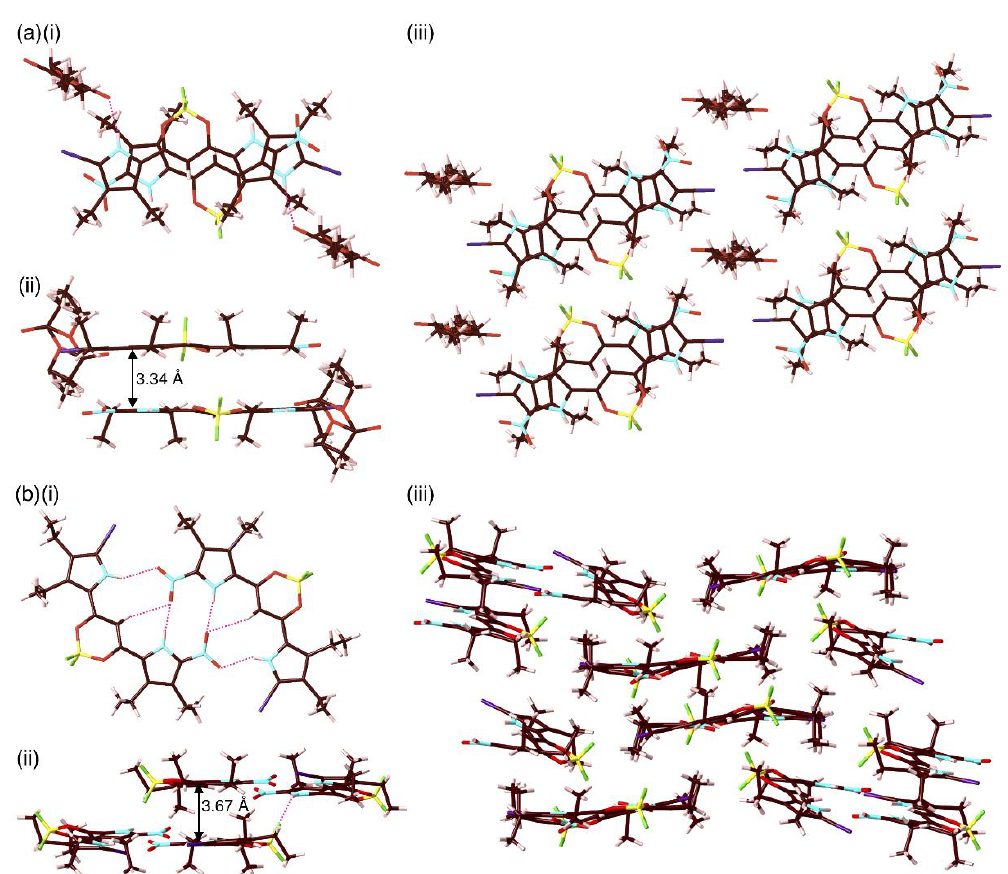
Figure 1. Single-crystal X-ray structures of ( a ) 2c -tri and ( b ) 2c -mono as ( i ) top and ( ii ) side views and ( iii ) packing diagrams. Atom color codes: brown, pink, yellow, cyan, red, green, and purple refer to carbon, hydrogen, boron, nitrogen, oxygen, fluorine, and iodine, respectively.